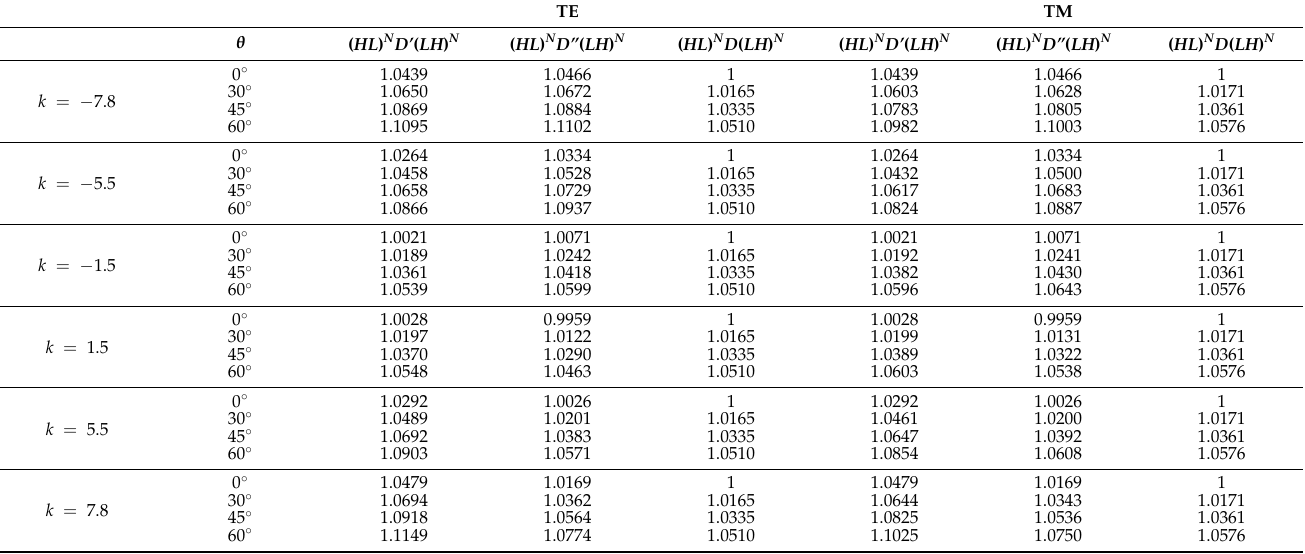
Figure 10. The transmission spectra of Model 5 ( HL ) N D (cid:48) ( LH ) N , Model 6 ( HL ) N D (cid:48)(cid:48) ( LH ) N and the reference Model ( HL ) N D ( LH ) N for different slopes k at incident angle θ = 45 ◦ for ( a ) TE and ( b ) TM polarizations, and ( c , d ) are the distributions of refractive index for different slopes k for the first- and second-order gradient defect D (cid:48) and D (cid:48)(cid:48) , respectively. Table 2. Defect mode frequencies (in unit ω / ω 0 ) of Model 5 ( HL ) N D (cid:48) ( LH ) N , Model 6 = n = ( HL ) N D (cid:48)(cid:48) ( LH ) N and the reference model ( HL ) N D ( LH ) N for n D (cid:48) D (cid:48)(cid:48)